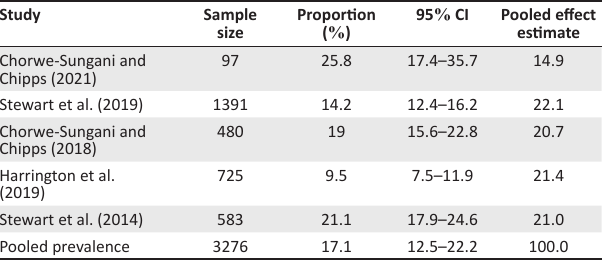
points ranged from ≥ 6 to >12. The second most-used instrument was SCID ( n = 2), followed by the Self-Reporting Questionnaire 20 ( n = 1), with a cut-off point ≥ 8, and the MINI ( n = 1) (Table 3). Open Access